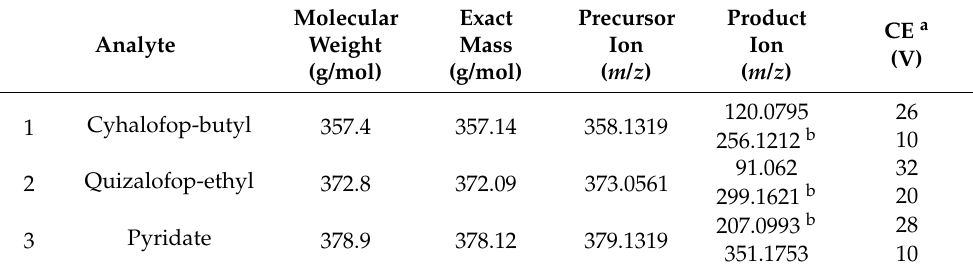
Table 5. Characteristic ions observed via LC-MS/MS for three residual